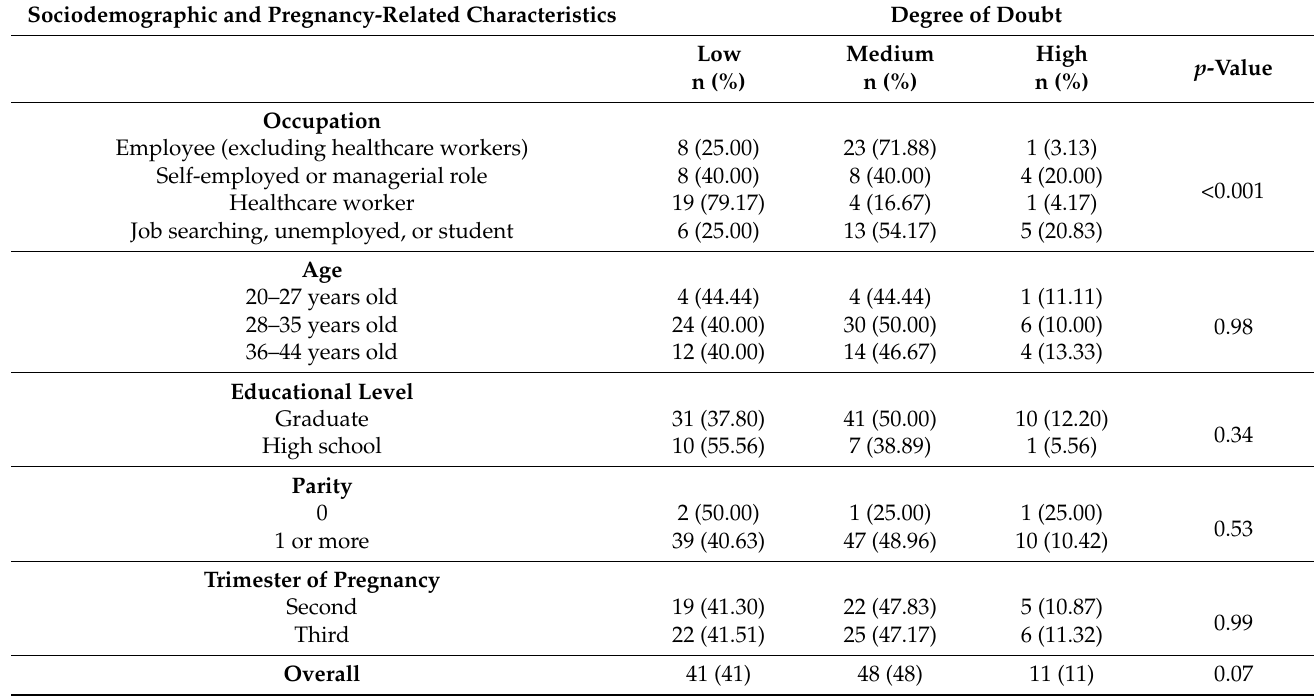
Table 4. Classification of the participants based on their degree of pre-vaccinal doubt (N = 100).